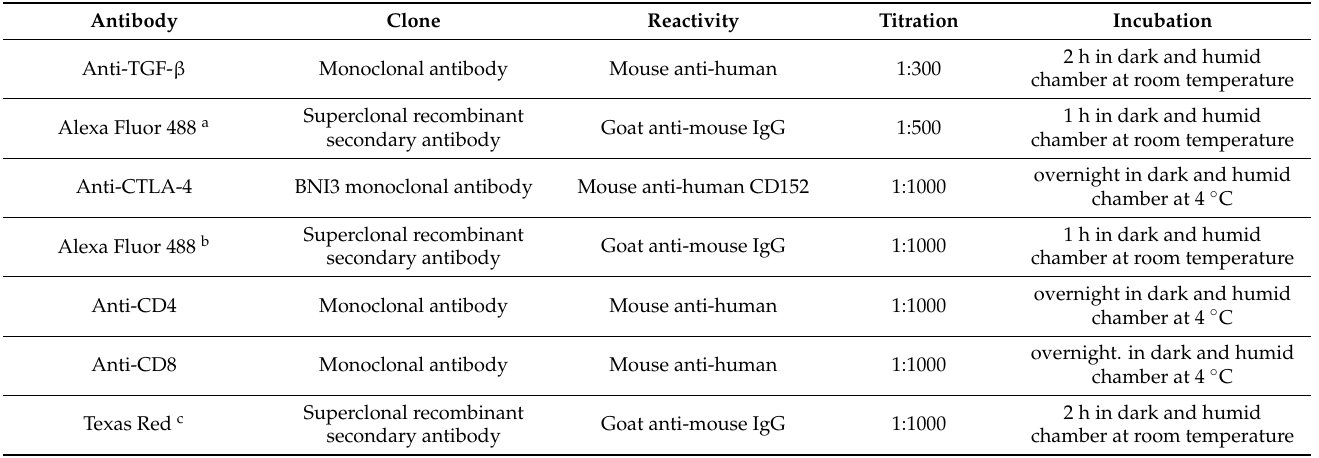
Table 2. Conditions of immunofluorescence reactions and antibody